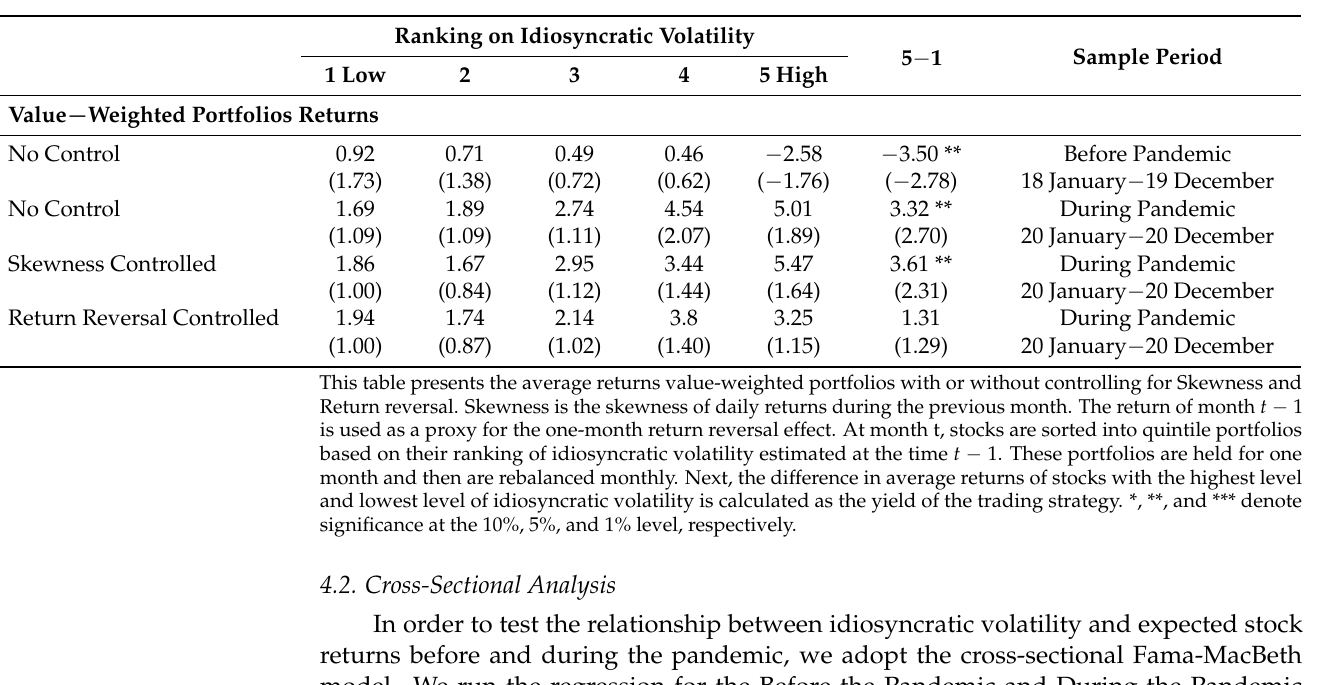
Table 2. Portfolio analysis for value-weighted